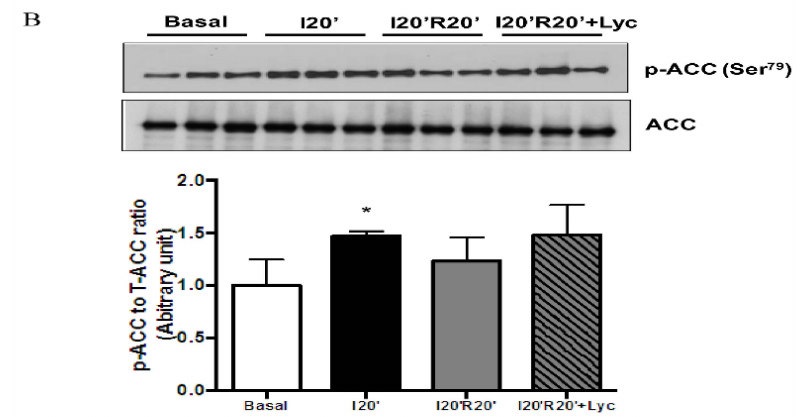
Figure 5. Effects of lycopene (Lyc) on fatty acid oxidation regulating signaling during in vivo I/R: ( A ) lycopene treatment moderately elevated AMPK phosphorylation at Thr 172 during reperfusion,